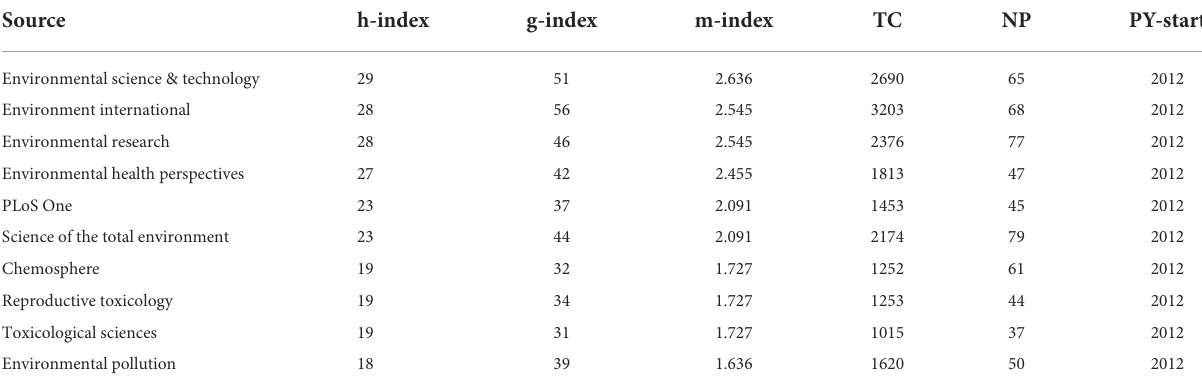
TABLE 4 Source impact of the top 10 journals publishing in this